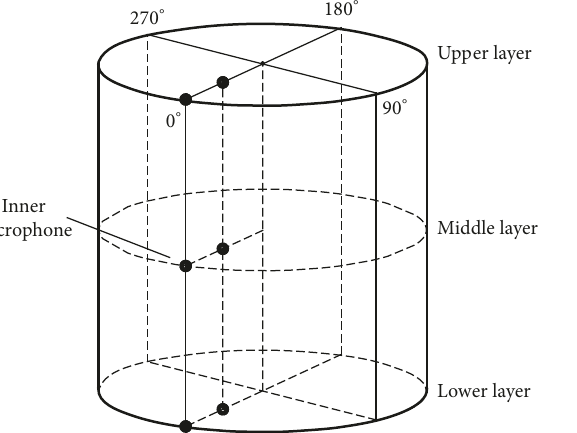
Figure 3: Sketch of arrangement of in-cavity acoustic microphones.